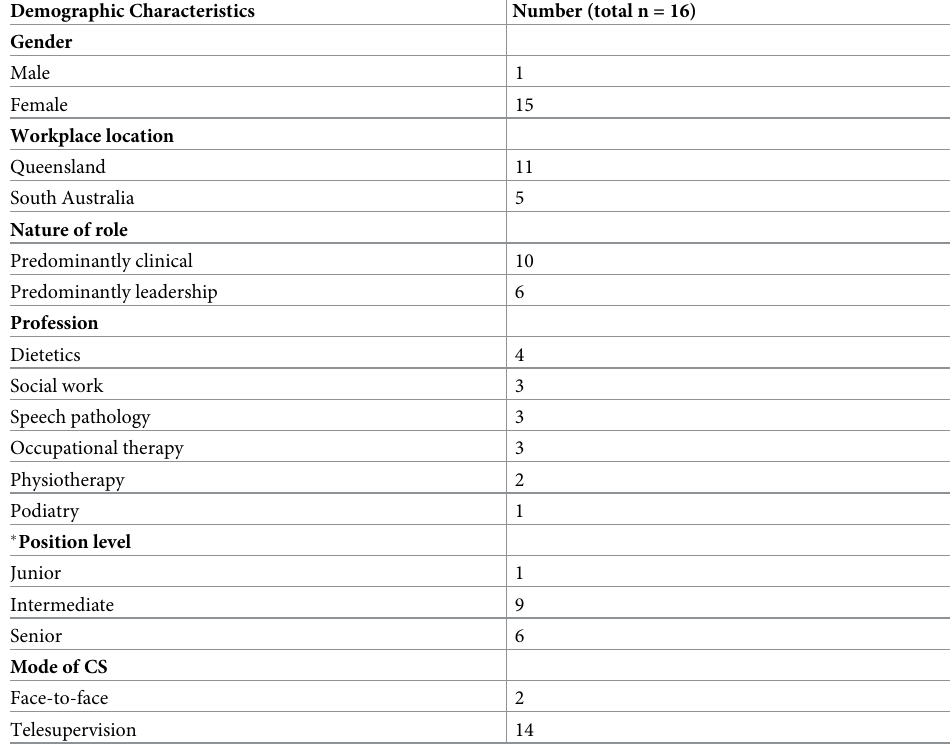
Table 1. Participant demographics and information about CS